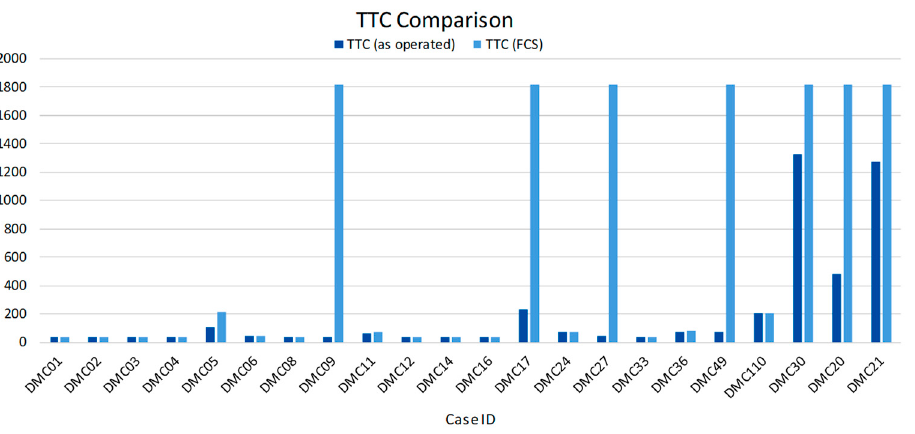
Figure 20. Time to capsize comparison on residual loss scenarios with and without AREST P1.